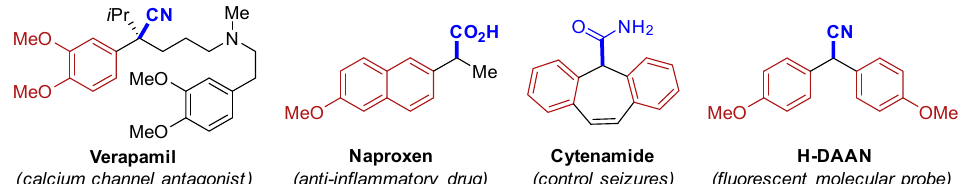
Figure 1. Verapamil, H-DAAN, and some derivatives of α -aryl